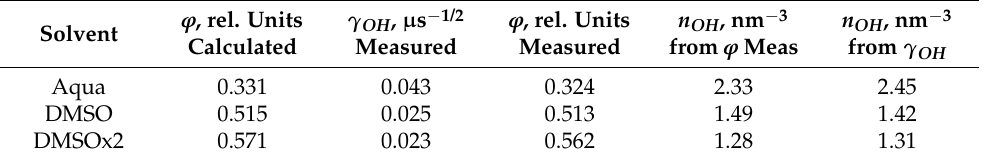
Table 1. Relative fluorescence quantum yield ϕ and concentration of OH- groups inside the NPs for three colloidal solutions of 0.1 at. % Nd 3+ : LaF 3 NPs. ϕ , rel. Units Solvent